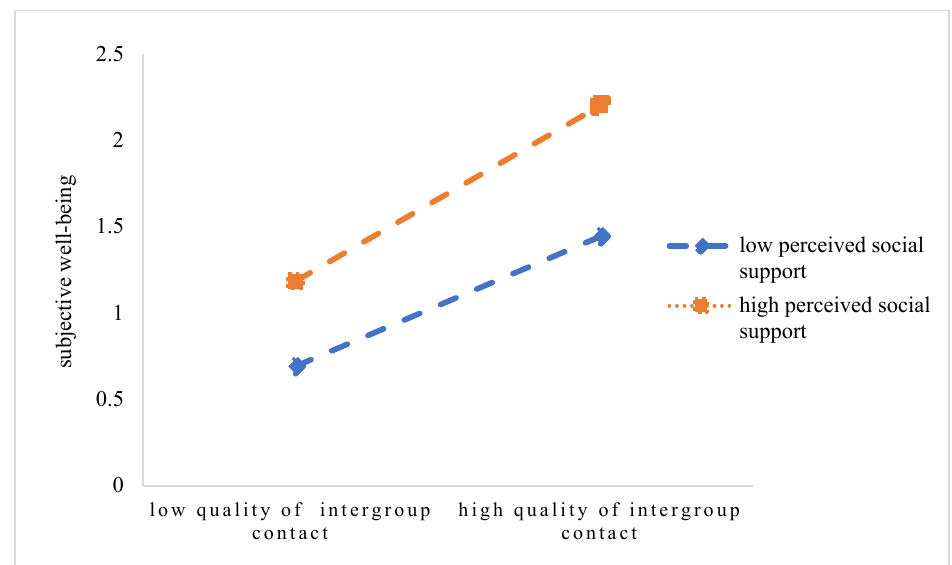
Figure 2. The interaction effects of quality of intergroup contact and social support on subjective well-being.